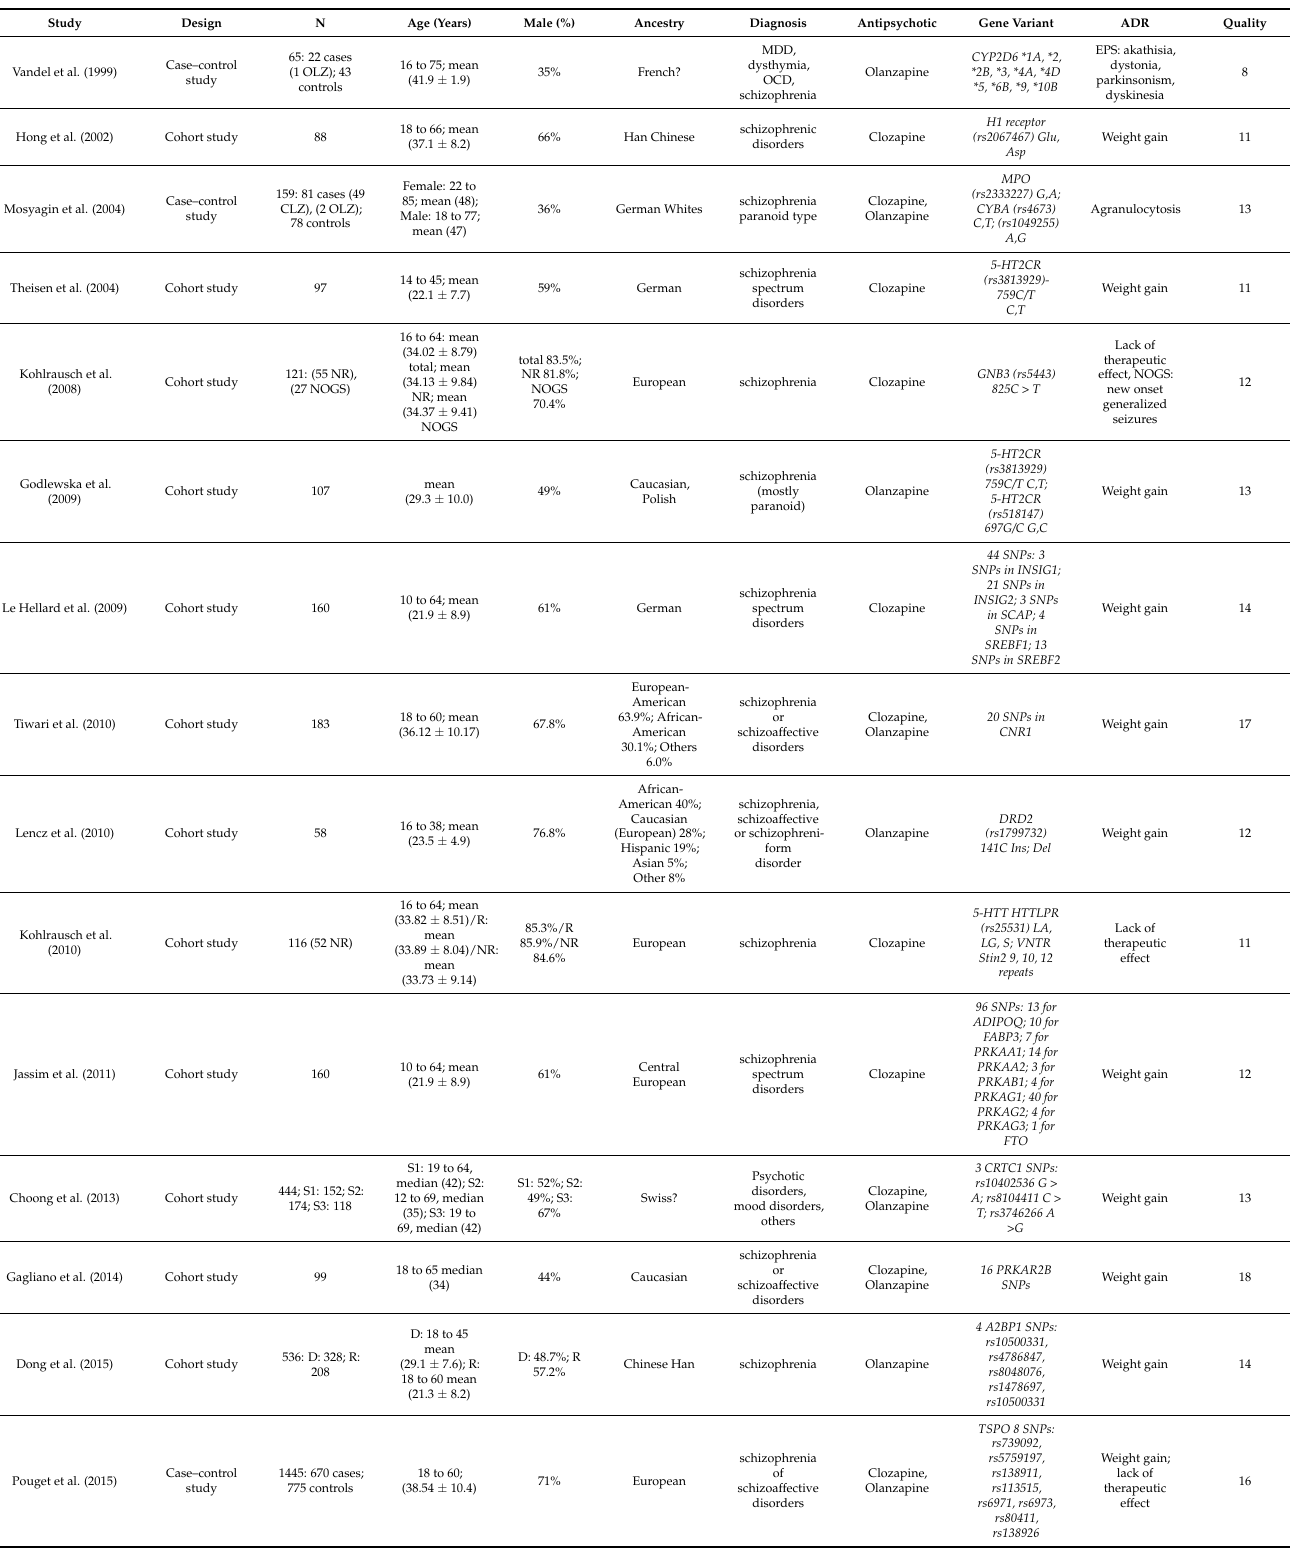
Table 2. Characteristics of the studies (mixed